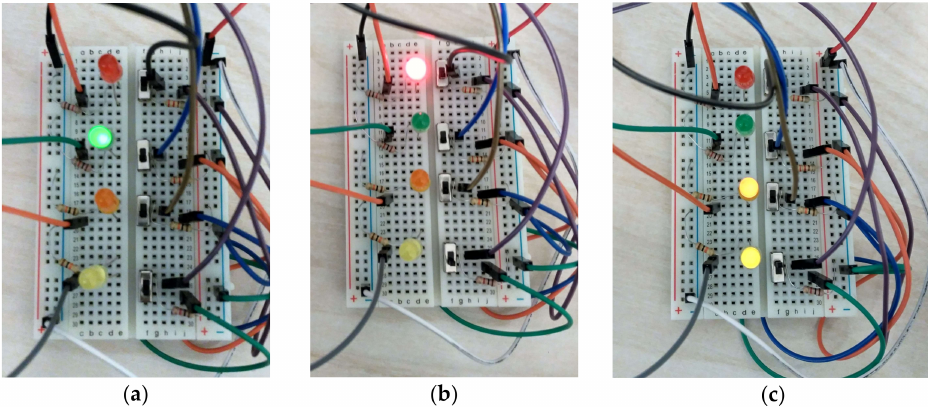
Figure 8. Different states of the robot as a result of the emulation: ( a ) alternating between turning and moving; ( b ) moving forward; ( c ) over the drop and openning the